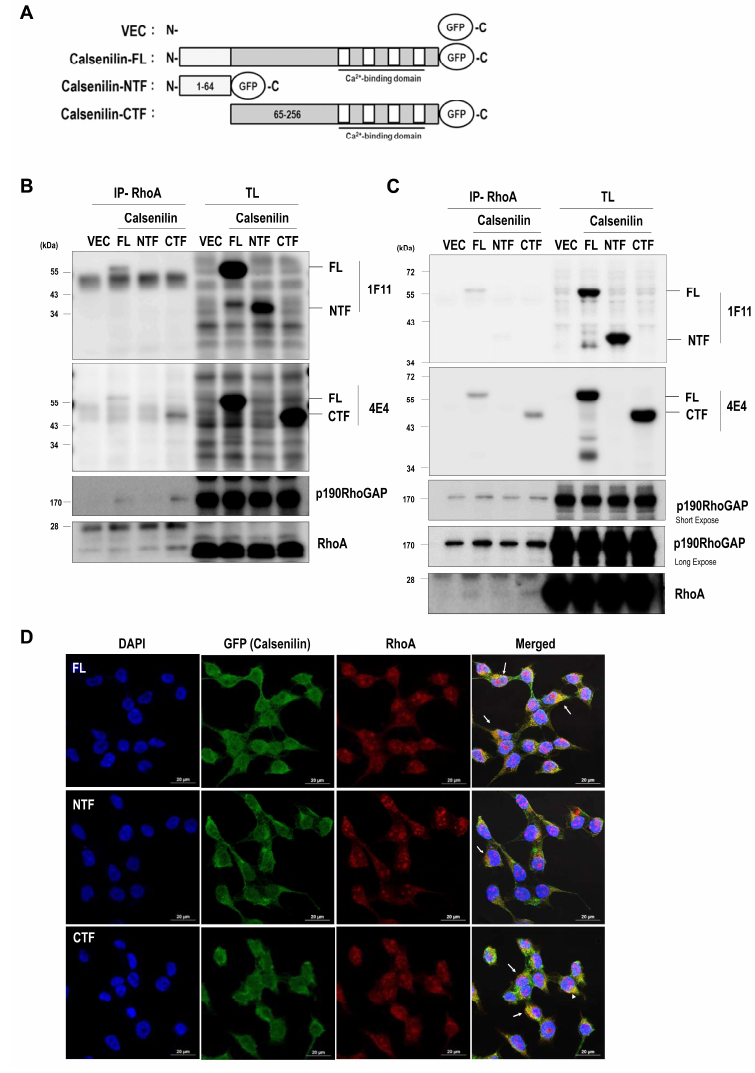
Figure 4. Calsenilin-CTF is responsible for the interaction with RhoA: ( A ) schematic diagram depicting the construction of the pEGFP-N1 vector, calsenilin-FL (aa 1–256), -NTF (aa 1–64), and -CTF (aa 65–256); ( B , C ) total lysates from HEK293 and PC12 cells expressing pEGFP-N1 vector alone (VEC), full-length calsenilin (FL), or truncated fragments (NTF or CTF) were immunoprecipitated with an anti-RhoA antibody and then analyzed by Western blotting with anti-calsenilin (1F11, amino acid 25-33; 4E4), anti-p190RhoGAP and anti-RhoA antibodies; and ( D ) the co-localization of calsenilin with RhoA in HEK293 cells expressing VEC, calsenilin-FL, -NTF, or -CTF was determined by double immunofluorescence staining using confocal microscopy. Green, calsenilin; Red, RhoA; Blue, DAPI. Scale bars, 20 μm.